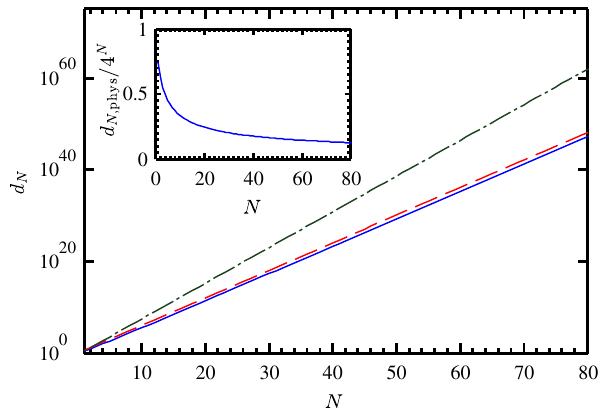
(blue solid N; phys max ¼